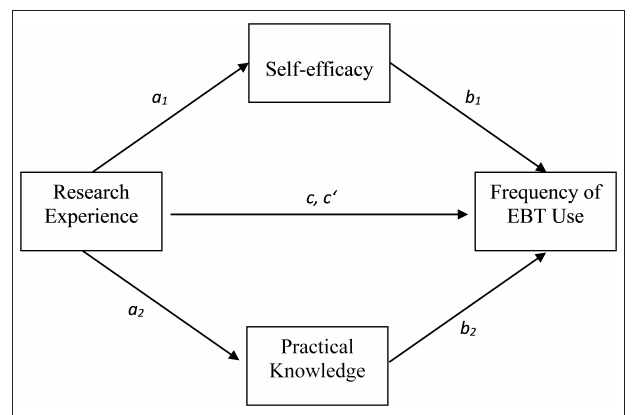
FIGURE 2 | Schematic representation of the overall mediation model with the two mediators.